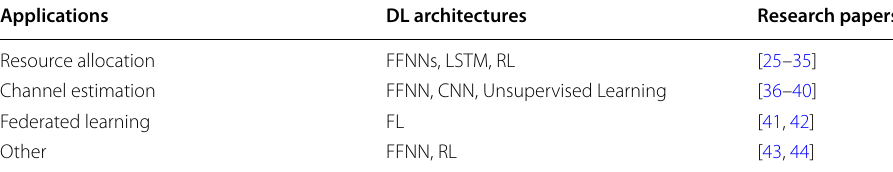
Table 1 DL methods for CF M-MIMO